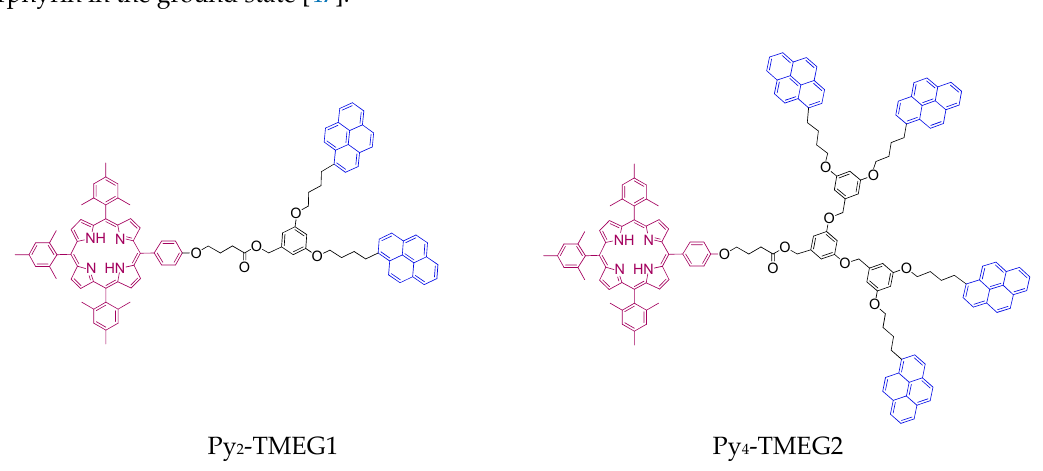
Figure 2. Structure of the dendronized porphyrins containing first-generation and second-generation Fréchet-type dendrons [47].